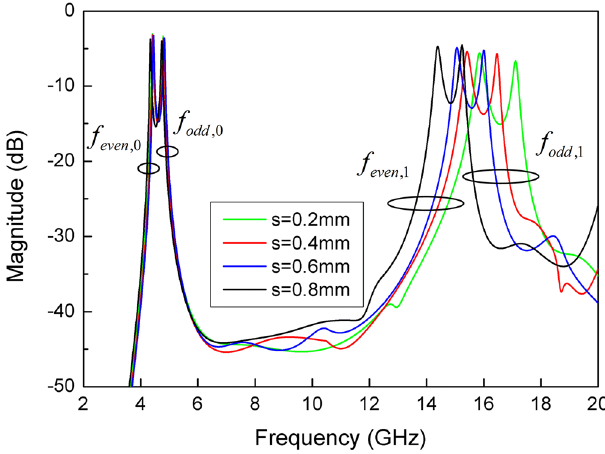
Figure 9. The simulated resonant modes of SSLSIR with different width s of slit line.